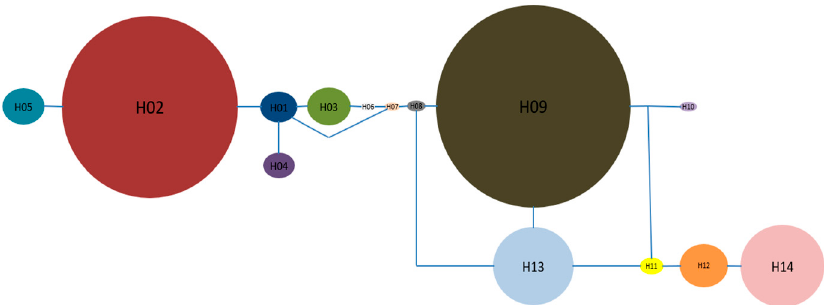
Figure 2. A network of mitochondrial haplotypes that were identified from concatenated sequences of cox1 − nad 1 and 26S − rRNA − tRNA − Leu. The circle sizes are proportional to the haplotype frequencies in 500 individuals. Code H i ( i = 1, 2, . . . ,14) represents the i th haplotype and each haplotype is an unique combination of multiple alleles at polymorphic nucleotide sites. Table 2 shows the haplotype and nucleotide diversity in 29 populations. The haplo- type diversity ranged from 0.000 to 0.508, with the average diversity of 0.190 (±0.202). Population Simao (SM) in Yunnan Province, had the highest diversity, ℎ = 0.5078, fol- lowed by Huangshan (HS, ℎ = 0.50) in Anhui Province and Nanping (NP, ℎ = 0.50) in Fujian Province. The nucleotide diversity was relatively higher in Yunfu (YF, 𝜋 = 0.00171) in Guangdong Province, Jinggangshan (JG, 0.00173) in Jiangxi Province, and Wuyishan (WY, 0.00148) in Fujian Province, and less than 0.001 in the remaining twenty-nine popu- lations. Average nucleotide diversity was 0.000383 (±0.000536). Table 2. Genetic diversity of T. ciliata complex derived from the concatenated sequences of mitochondrial cox1 − nad 1 and 26S − rRNA − tRNA − Leu, and the nrDNA ITS sequences. mtDNA Marker Haploid nrDNA ITS Tajima’s D Population